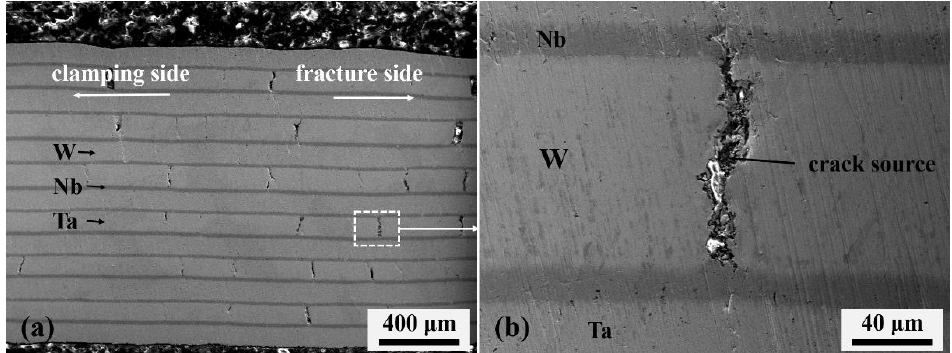
Figure 6. ( a ) The side morphology of W / Nb / Ta specimen after tensile fracture, ( b ) magnified views of Figure 6. The side morphology of W/Nb/Ta specimen after tensile fracture. Figure 6. The side morphology of W/Nb/Ta specimen after tensile fracture. W crack